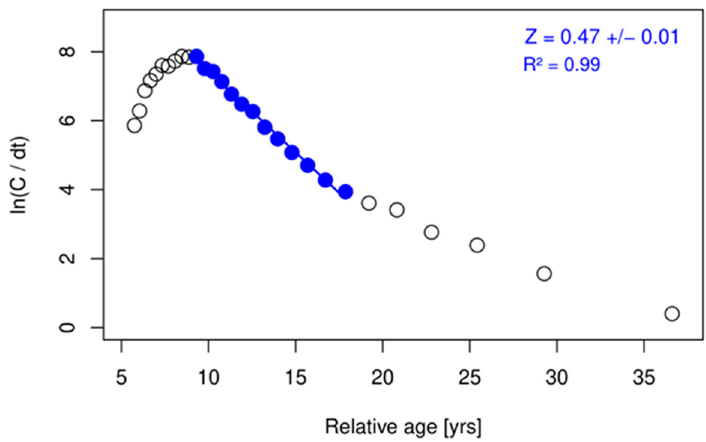
Figure 8. Estimate of total mortality ( Z ) with the linearized length-converted catch curve for Lepidopus caudatus in the Azores using data for pooled sexes from official landings